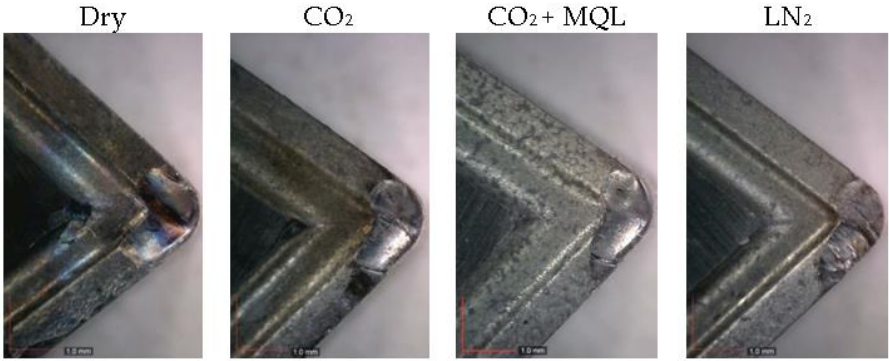
Figure 7. Images of crater wear occurring after 500 mm cutting length.